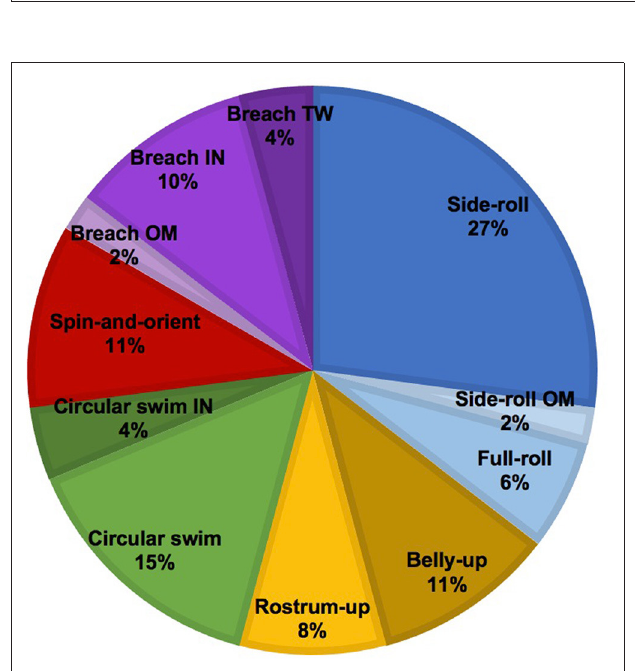
FIGURE 4 | Pie chart illustrating the relative proportion of each response behavior of bottlenose dolphins. Modifiers: OM, Open-mouth; IN, Inverted; TW, Twist.